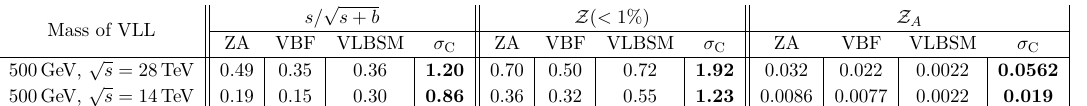
Table 8. Signal significance for the lightest VLL. The computation follows an evolutive algorithm that maximizes the Asimov significance metric. All significances are computed for L = 3000 fb − 1 for a fixed mass m E = 500 GeV. In the first row, computations are performed for the centre-of-mass √ √ 2 s = 28 TeV, while the case of s = 14 TeV is in the second row. σ C is the combined energy of significance as defined in